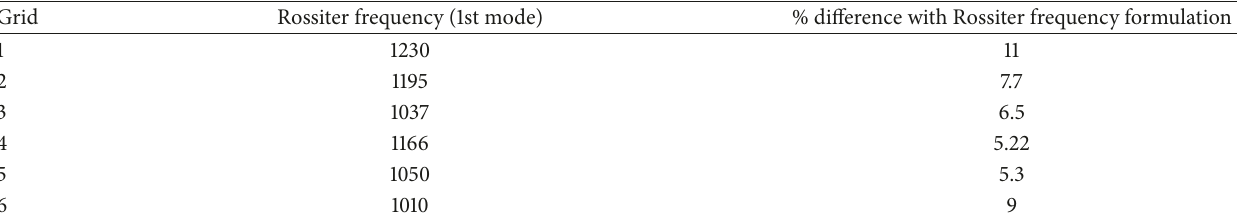
Table 4: Frequency predictions with different grid resolutions.